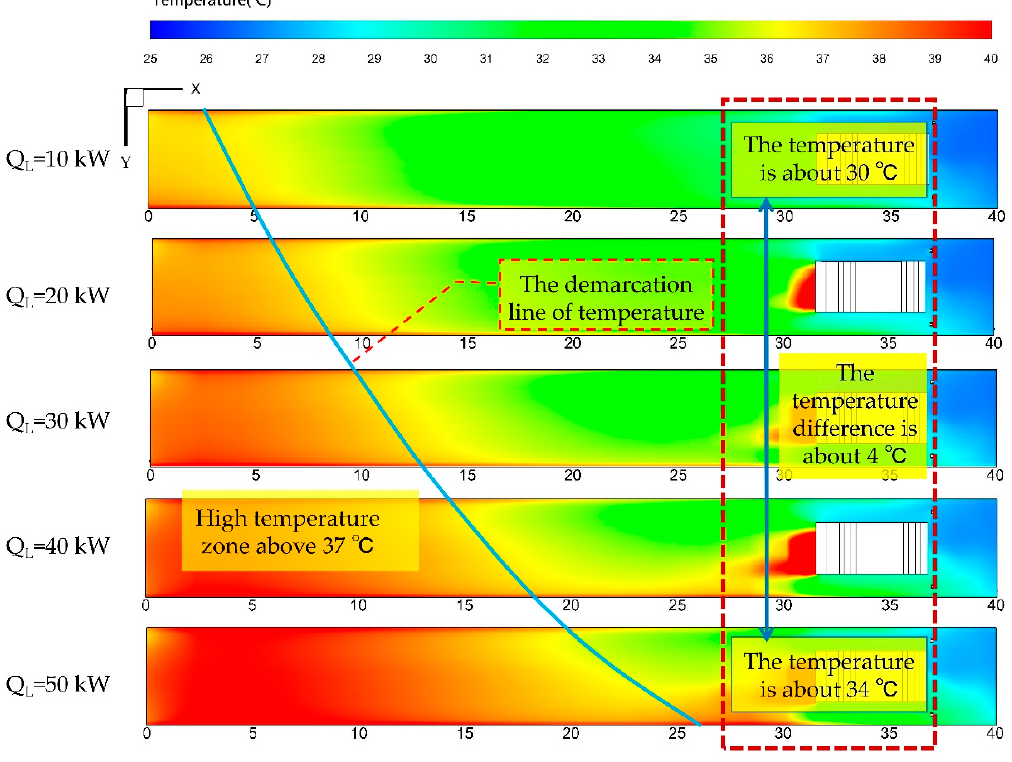
Figure 18. Airflow temperature distributions in Plane B with different Q L.